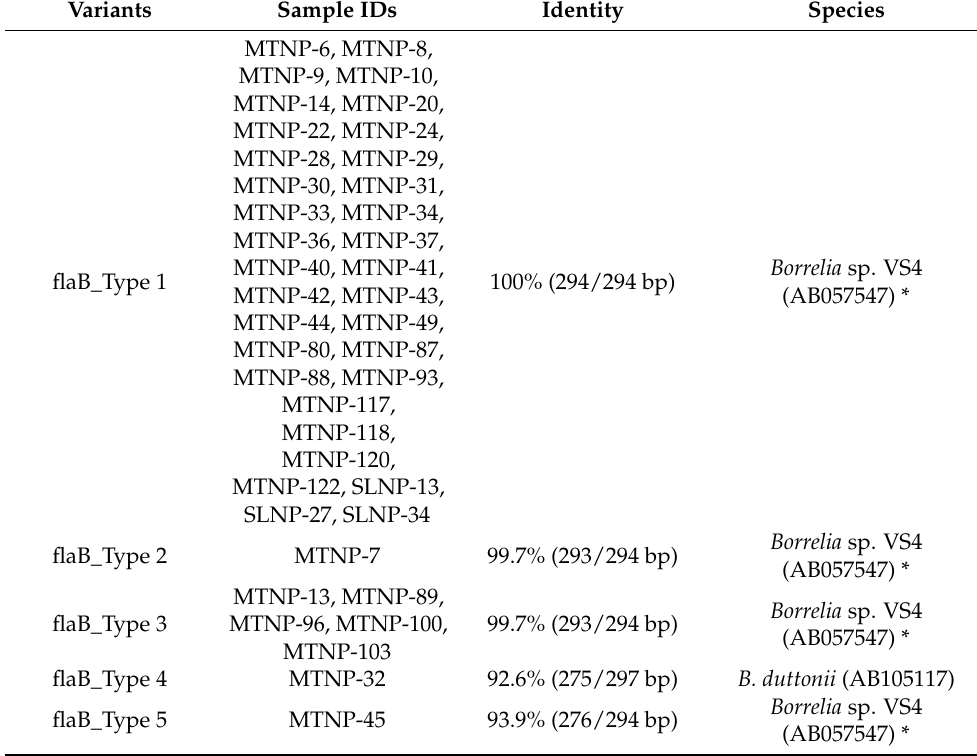
Table 2. Results of BLASTn search of flaB sequences